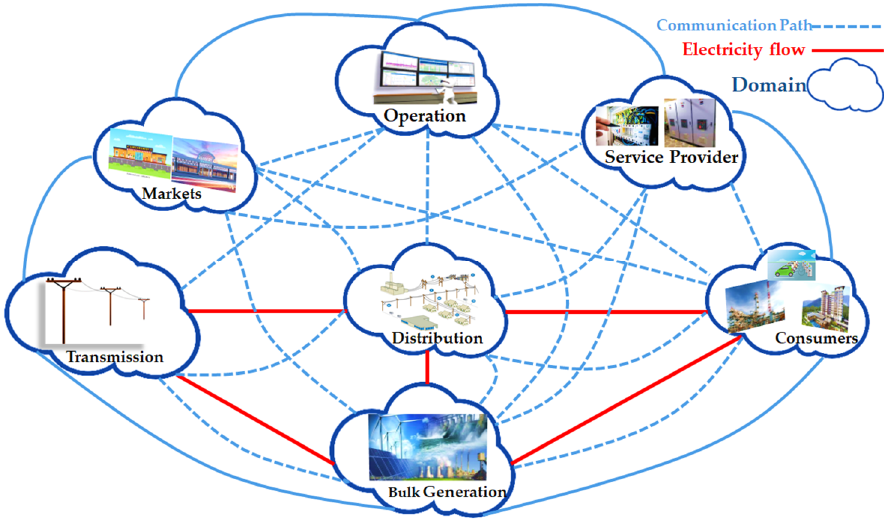
Figure 2. SG communication network architecture [16].